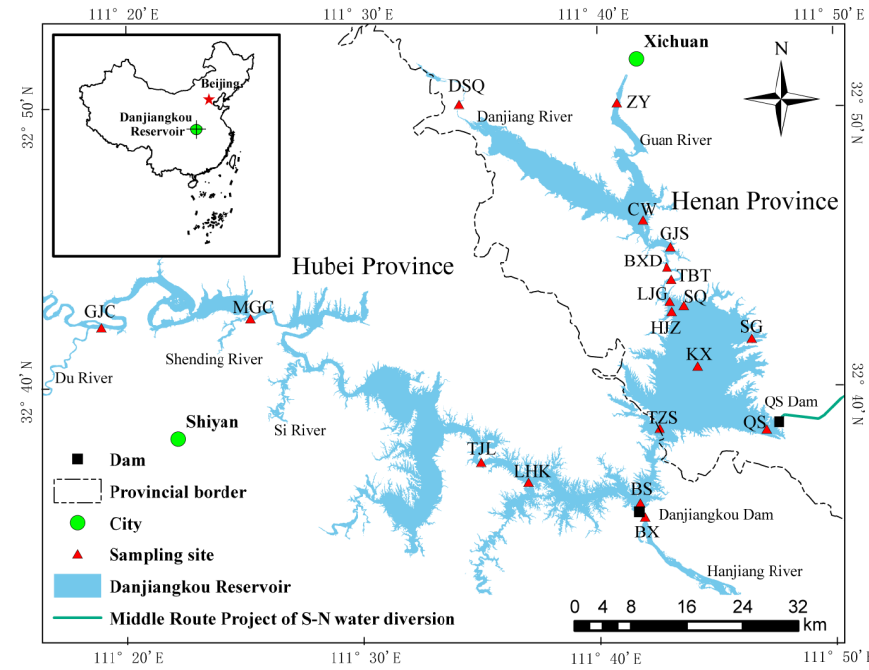
Figure 1. Distribution map of sampling sites in the Danjiangkou Reservoir.